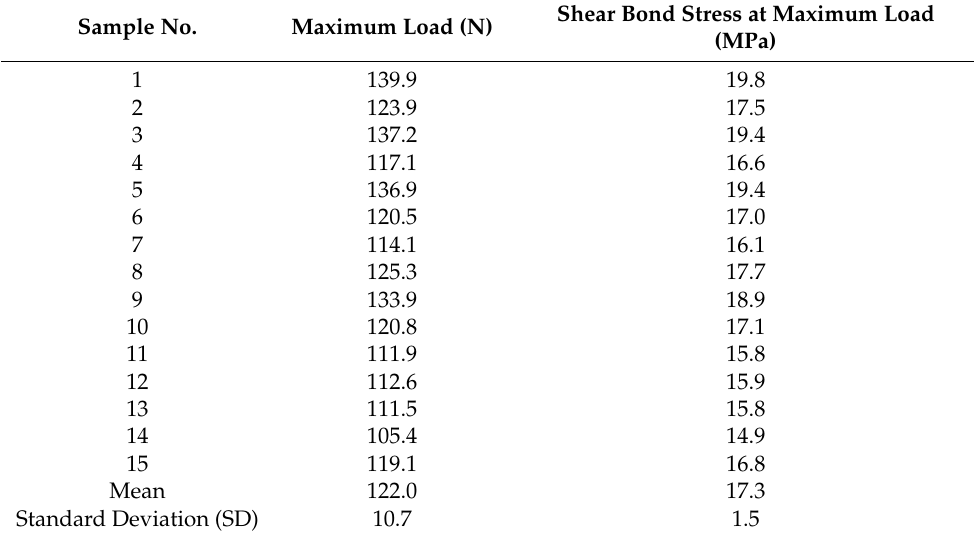
Table 2. Shear bond strength for Group I specimens ( n = 15).